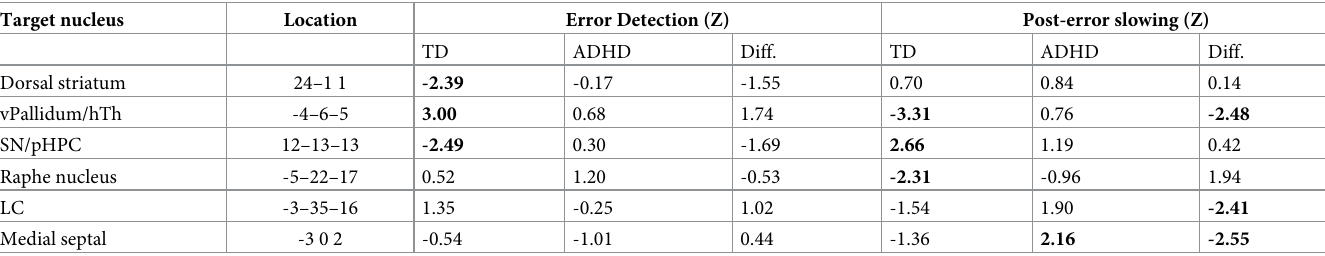
Table 1. Seed activities during error detection and post-error